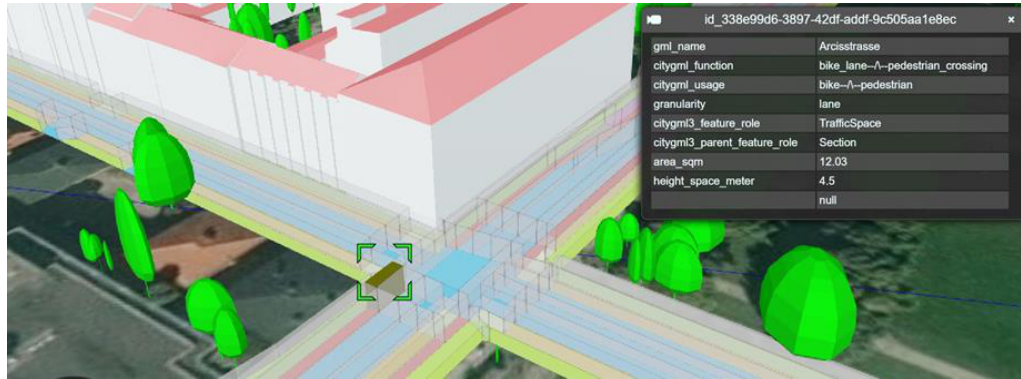
Figure 15. Demo of CityGML 3.0 concepts for an area around TU Munich.